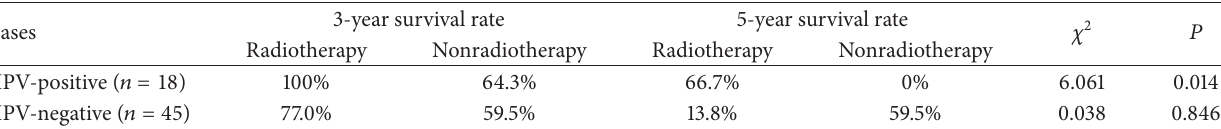
Table 3: The impact of HPV infection status on the prognosis of patient receiving radiotherapy or nonradiotherapy.